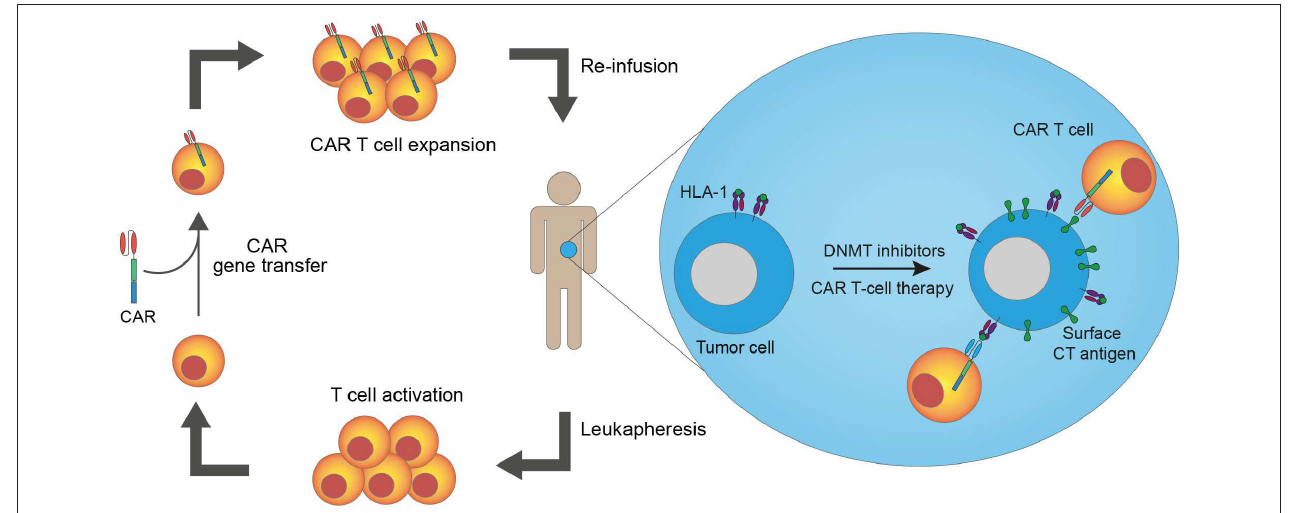
FIGURE 1 | Epigenetic pre-treatment sensitizes cancer cells to cancer/testis antigen-directed CAR T-cell therapy. T cells from a patient are harvested through leukapheresis. The T cells are activated and genetically modified to express chimeric antigen receptors (CARs) ex vivo before they are expanded and reinfused into the patient. Pre-treatment of patients with epigenetic drugs, such as DNA methyltransferase (DNMT) inhibitors, increases cancer/testis (CT) antigen and HLA-I expression on cancer cells, leading to enhanced recognition of cancer cells by CAR T cells. Both CAR T cells made from conventional antibodies and TCR mimic antibodies (recognizing antigen peptides presented in complex with HLA-I) are available